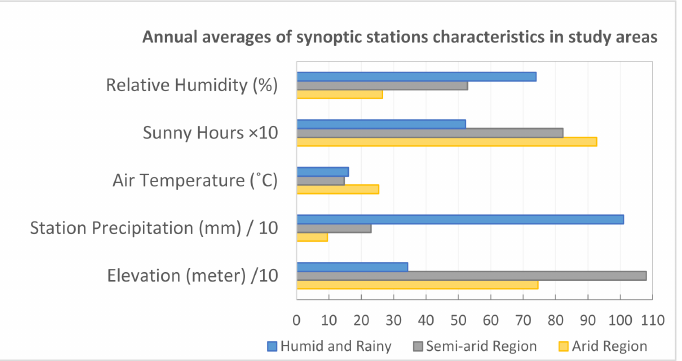
Figure 2. Annual average of environmental characteristics and elevation in the study areas.